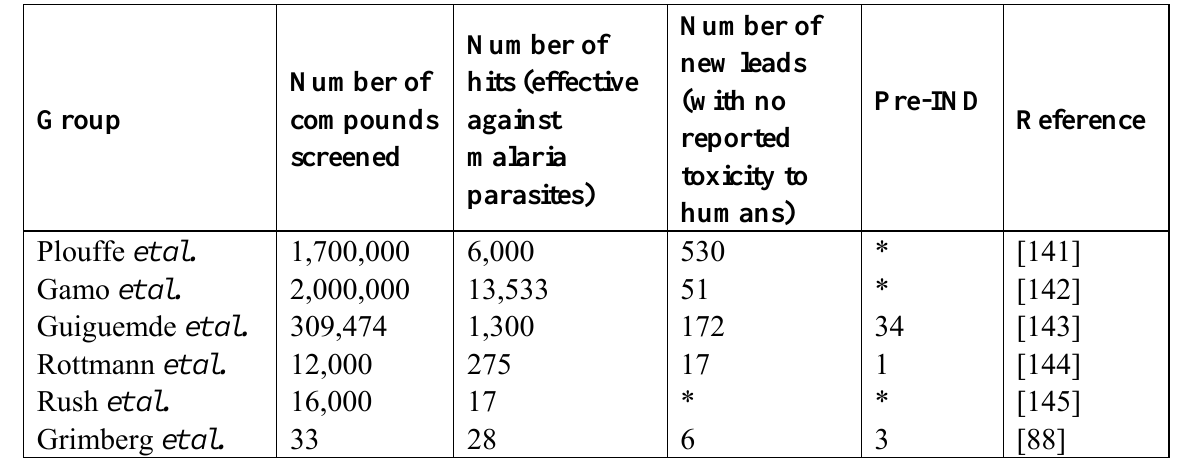
Table 1. Recent antimalarial drug screening